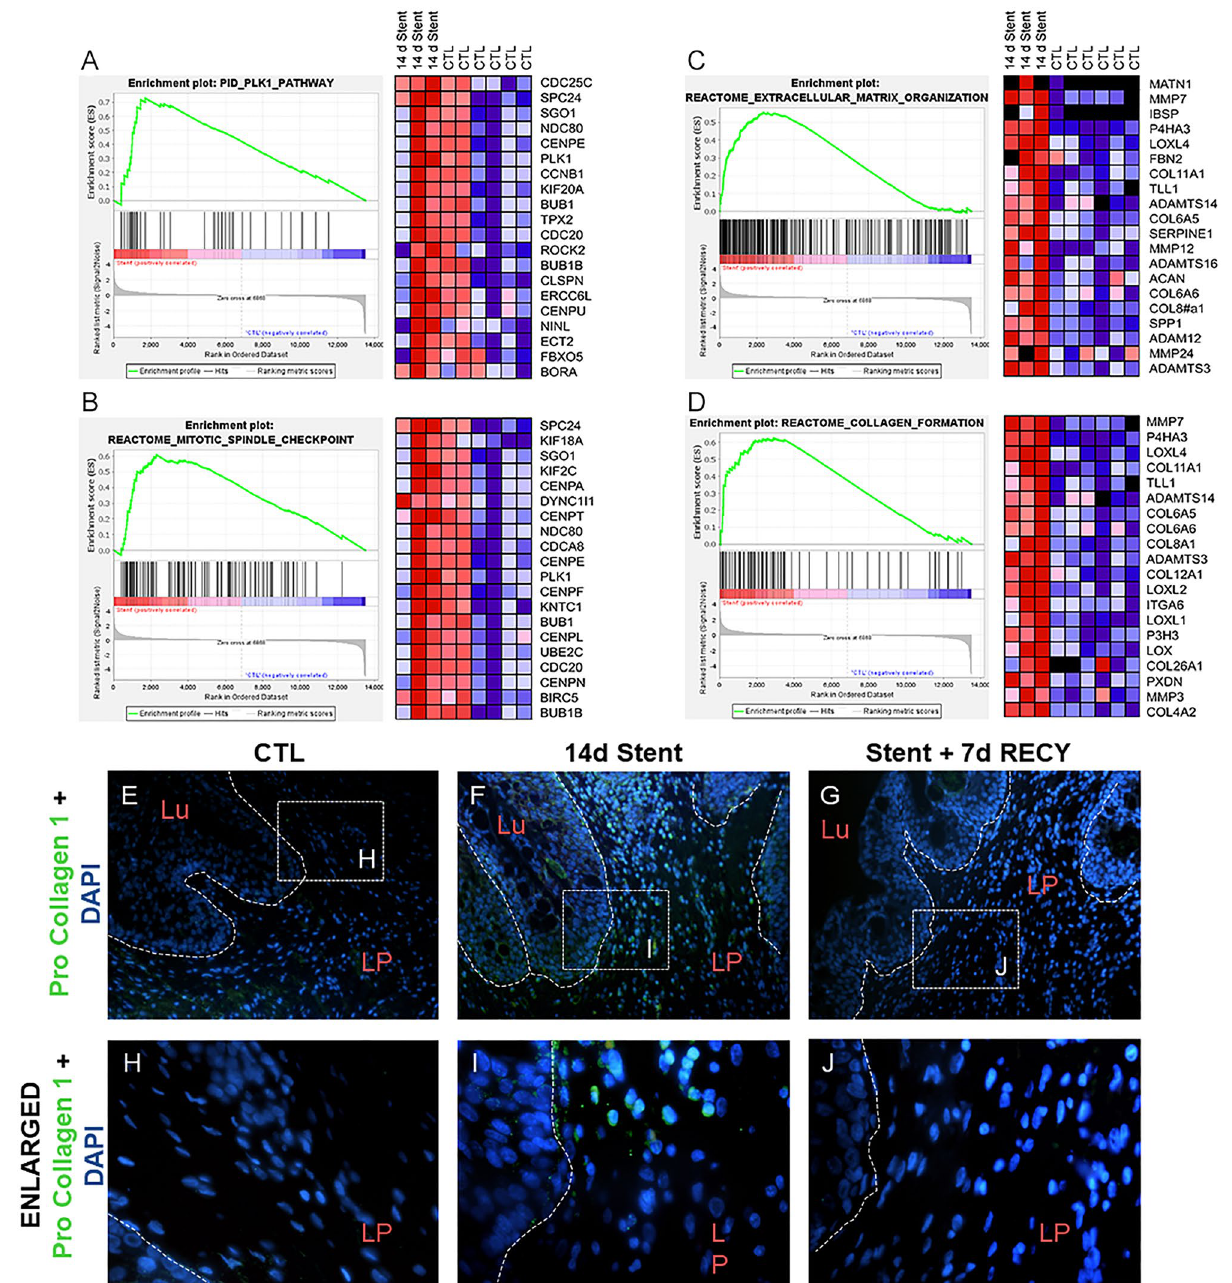
Figure 6. Fibrosis and cell proliferation in stented ureters. Changes in gene expression induced by 14 days of ureteral stenting compared to control ureters. ( A ) Left: curated enrichment plot for PLK-1 gene set; right: heat- map of top 20 PLK-1 gene set enriched in stented ureters. ( B ) Left: curated enrichment plot for extracellular matrix organization gene set; right: heat-map of top 20 genes extracellular matrix organization gene set enriched in stented ureters. ( C ) Left: curated enrichment plot for Reactome mitotic spindle checkpoint response gene set; right: heat-map of top 20 genes of Reactome mitotic spindle checkpoint gene set enriched in stented ureters. ( D ) Left: curated enrichment plot for Reactome collagen formation gene set; right: heat-map of top 20 genes of Reactome collagen formation signaling gene set enriched in stented ureters. ( E–J ) Immunofluorescence of control (CTL), 14d stented (14d Stent) and 14d stented followed by 7d recovery (14d Stent + 7d RECY) ureters. Low and high magnification images showing positive staining for Pro-Collagen 1 in 14d stented ureters. Lu lumen of the ureter, LP lamina